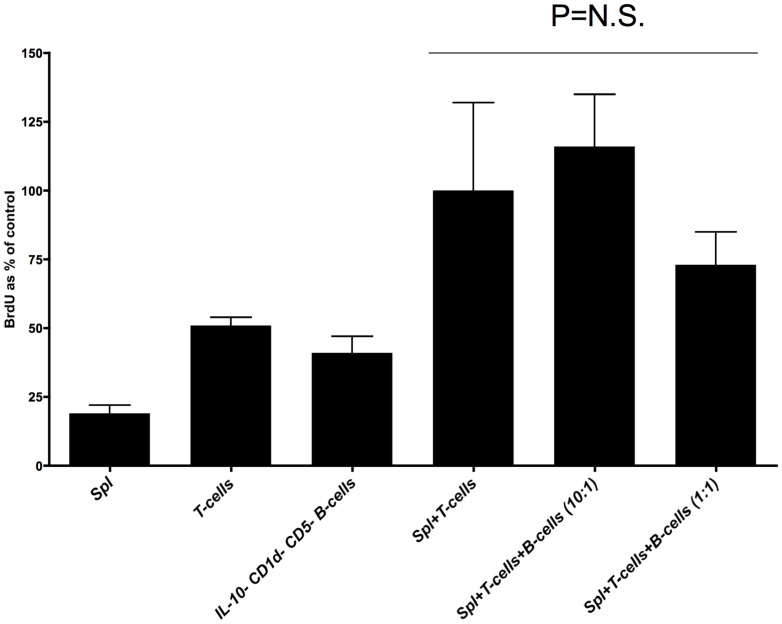
B10 Breg-depleted DC-Bregs are not suppressive in allogeneic MLR in vitro.The graph shows the frequency of BrdU-positive (proliferating) T-cells from freshly-isolated spleen of IL10gfp transgenic mice in the presence or absence of syngeneic CD1d, CD5, IL-10-depleted B-cells (represented in the graph as “IL-10− CD1d− CD5− B-cells”) and allogeneic, irradiated splenocytes (Spl). The B-cells (DC-Bregs or B10 Breg-depleted DC-Bregs) were added at a 1∶1 or a 1∶10 ratio of B-cells∶T-cells. The frequency of BrdU+ cells was measured by flow cytometry and the data are shown as BrdU+ cells as a % of control, where control refers to the frequency of proliferation of T-cells in the presence of only irradiated allogeneic splenocytes (taken to be 100%). The bars represent the mean and the error bars the SEM (triplicate culture dish wells). The differences in proliferation of T-cells among the co-cultures were not statistically-significant (p = 0.118, ANOVA) The data are representative of two independently-conducted experiments.